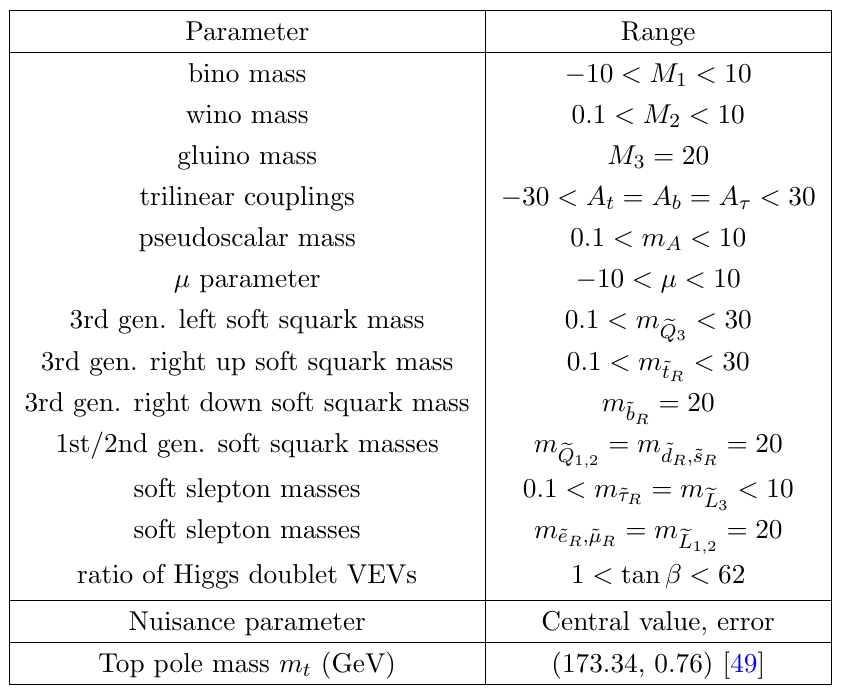
Table 2. Ranges of the p9MSSM parameters used in our scans. All masses and trilinear couplings are given in